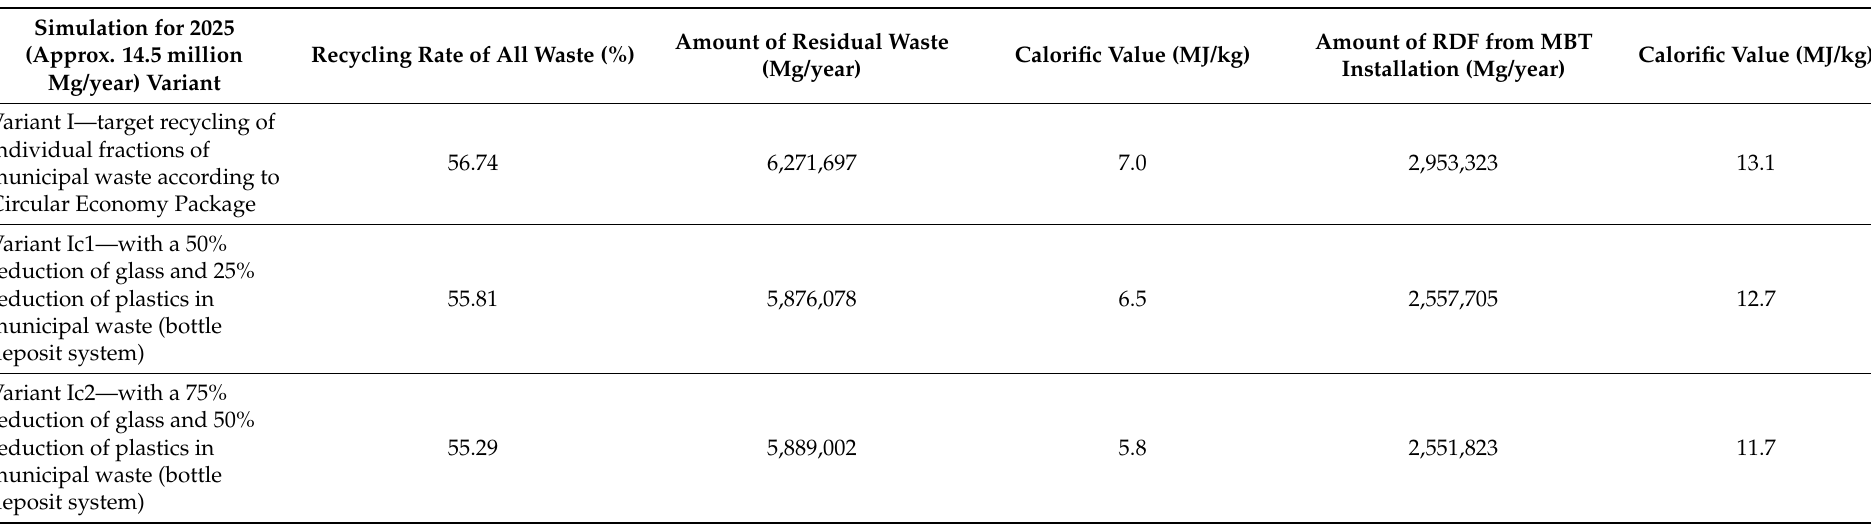
Table 13. The amount and calorific value of residual waste and RDF for various variants of the Circular Economy Package implementation—the impact of simultaneous reduction in the amount of glass and plastics in municipal